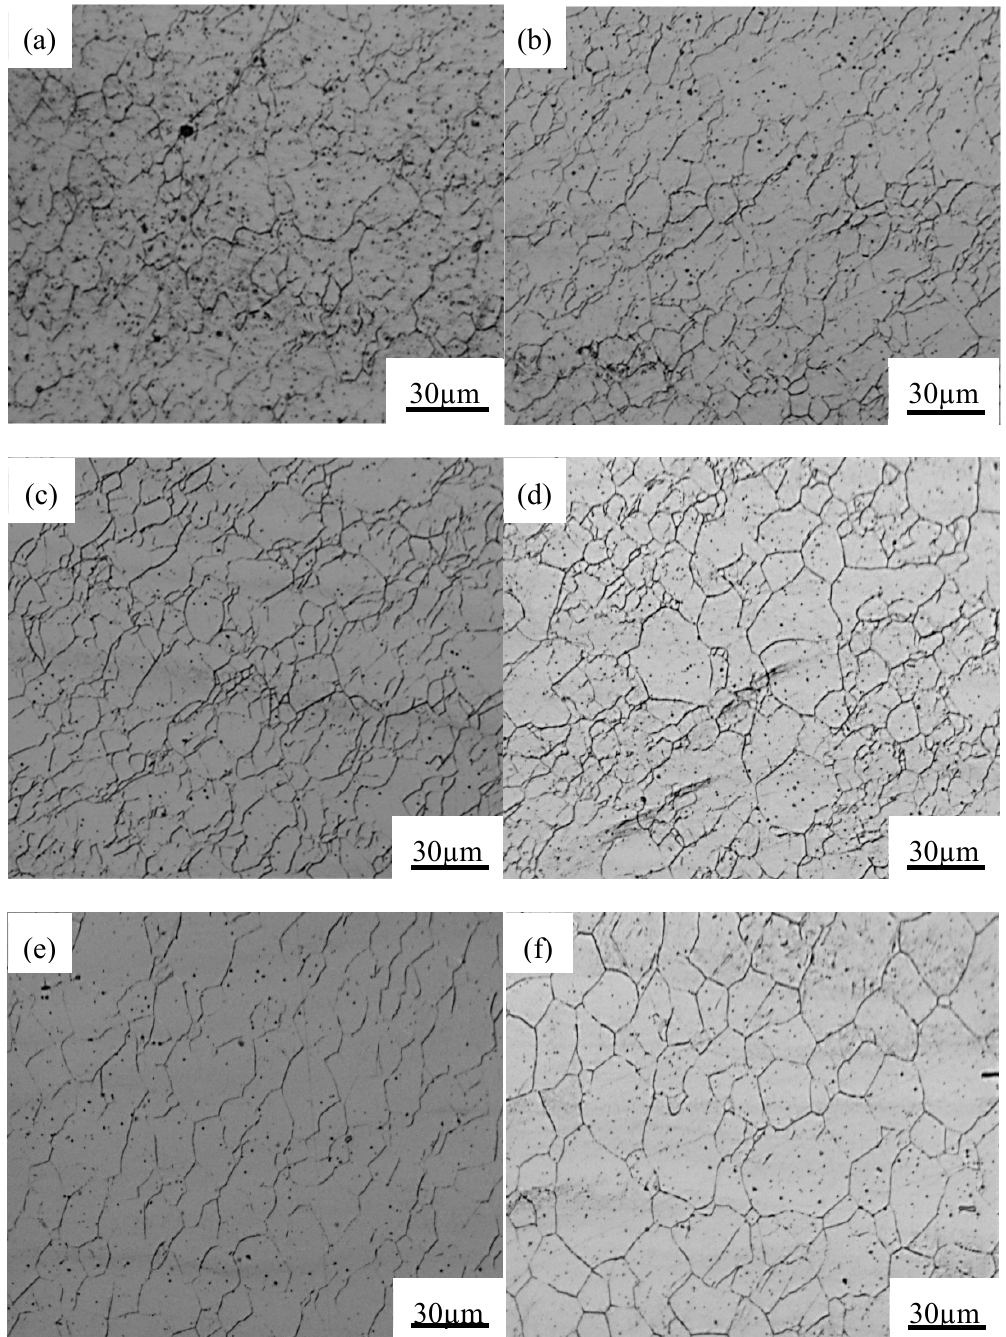
Figure 13. Optical microstructures of H13-mod steel in the flow stability region at deformation conditions of ( a ) 1050 °C, 0.01 s − 1 , ( b ) 1100 °C, 0.01 s − 1 ( c ) 1150 °C, 0.01 s − 1 , ( d ) 1150 °C, 0.1 s − 1 , ( e ) 1100 °C, 1 s − 1 ( f ) 1150 °C, 1 s − 1 .